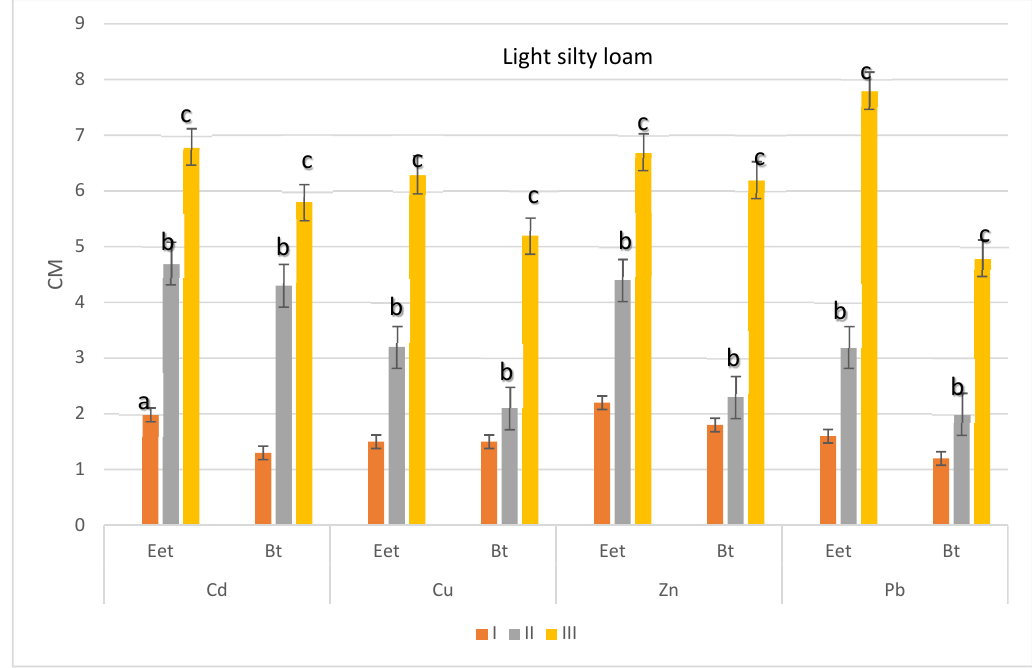
Figure 5. The mobility coefficients (CM) for Cd, Cu, Zn and Pb determined in HCl (1 mol·dm − 3 ) in Et and Bt levels in medium soil depending on the degree of contamination of the soils with these elements. a,b,c—treatments with the same letter are not significantly different ( p ≤ 0.05), Et—the subsurface horizon of eluvial loss of silt and clay, Bt—the subsurface horizon of illuvial accumulation of clay and humic